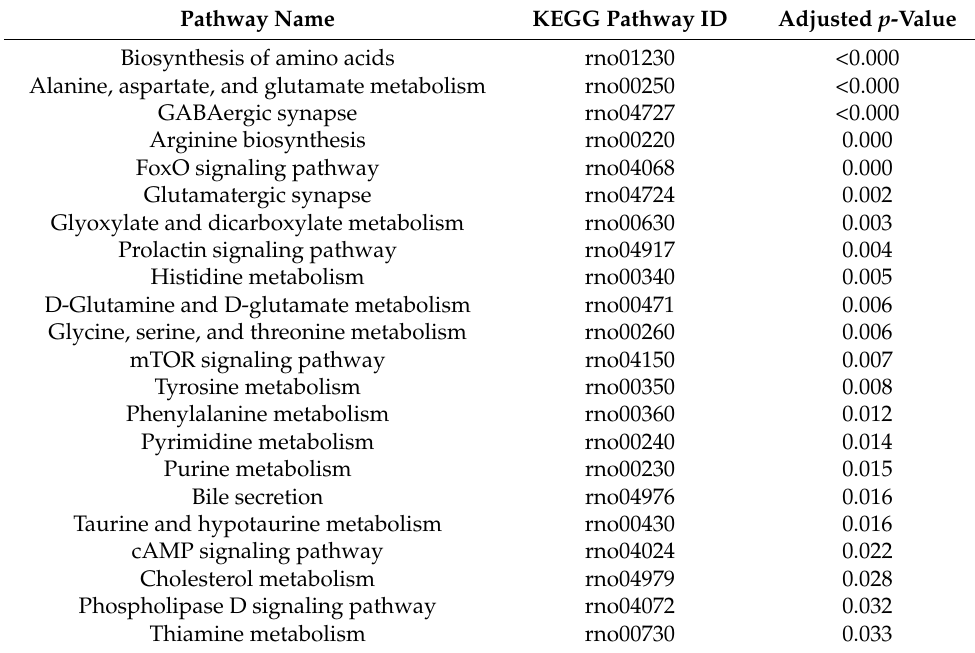
a . The 100% plant protein group vs. the 100% animal protein group. Table 8. Differential metabolic pathways between 100% plant protein group and animal protein